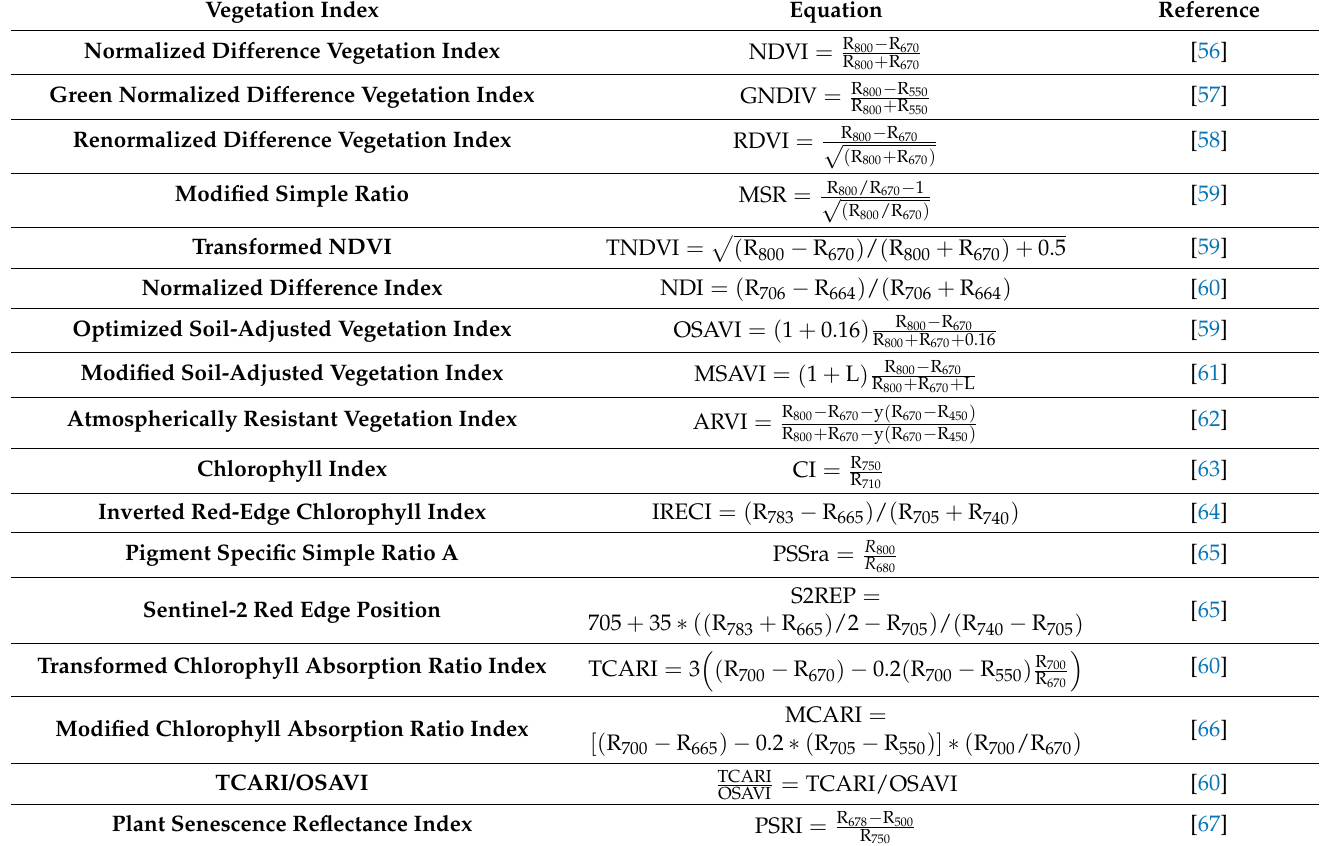
Table 2. Description of spectral features derived from